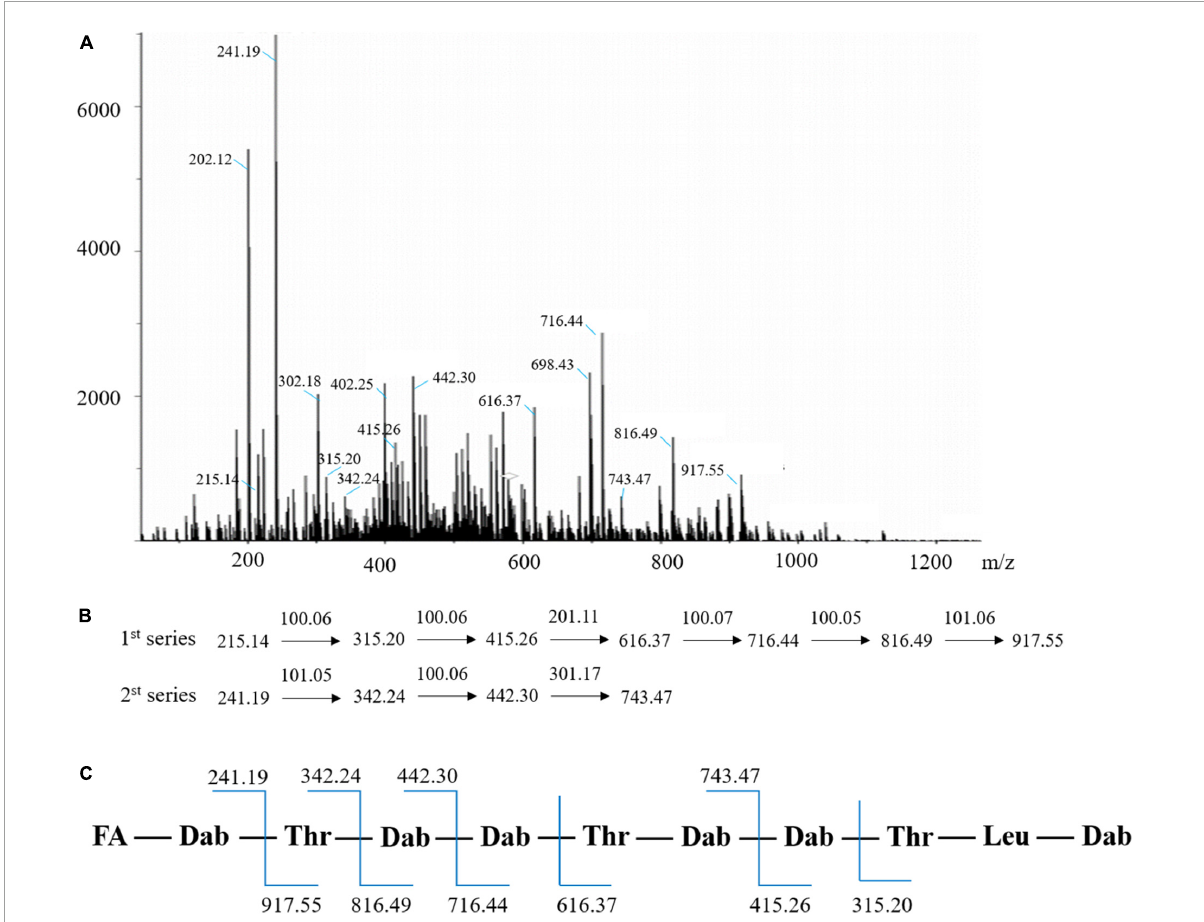
FIGURE7 Verification of the antimicrobial agent as polymyxin A1 by LC-MS/MS and amino acid analysis. (A) MS/MS spectra acquired for the m/z = 1157.7359; (B) fragment ions (m/z); (C) proposed linear structure for the antimicrobial agent polymyxin A1. FA: 6-methyloctanoic acid (C 9 H 17